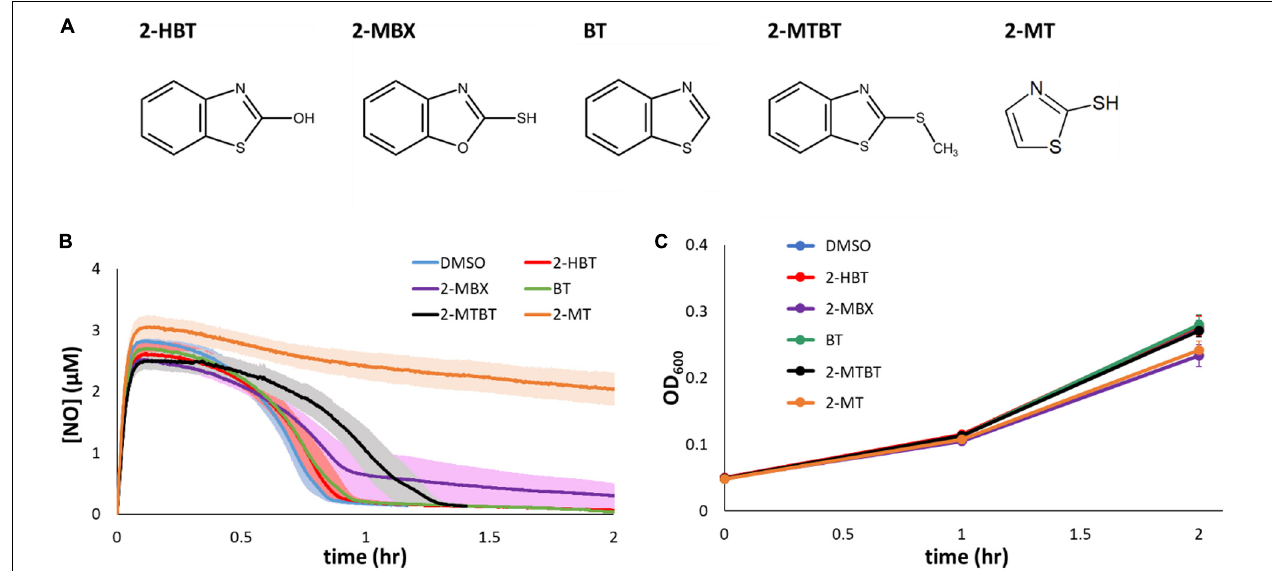
FIGURE 5 | Chemical analogs of 2-MBT and their effects on NO detoxification and growth. (A) 2-hydroxybenzothiazole is abbreviated as 2-HBT, 2-mercaptobenzoxazole as 2-MBX, benzothiazole as BT, 2-(methylthio)benzothiazole as 2-MTBT, and 2-mercaptothiazole as 2-MT. Structures were drawn using ACD/ChemSketch (ACD/ChemSketch, 2020). (B) [NO] in the bioreactor was monitored following treatments of DPTA and analogs of 2-MBT or DMSO. Solid lines represent the average measurements from at least 3 biological replicates and the shading the standard errors of the means. (C) Bacterial growth in the presence of